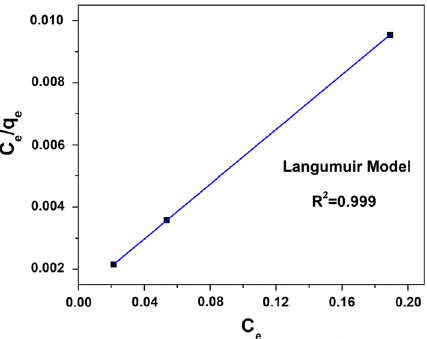
Fig. 9 Langmuir adsorption isotherm curve of Cr(VI) adsorption on CTAB–kaolin